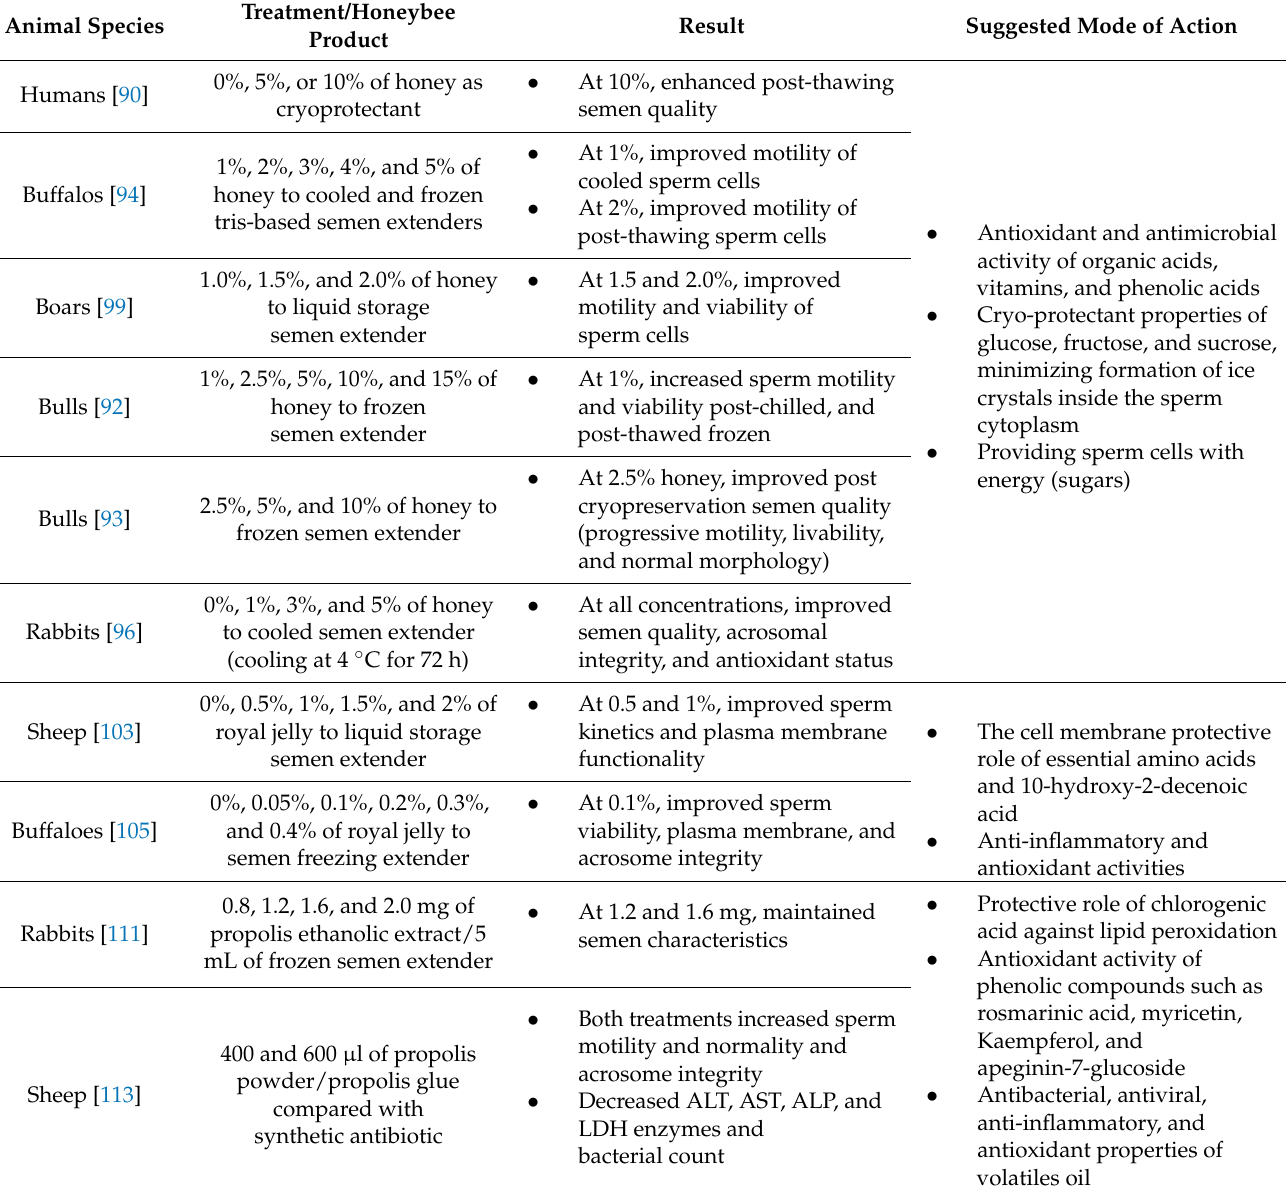
Table 5. Effect of honeybee products on assisted reproductive techniques (ARTs) in males.